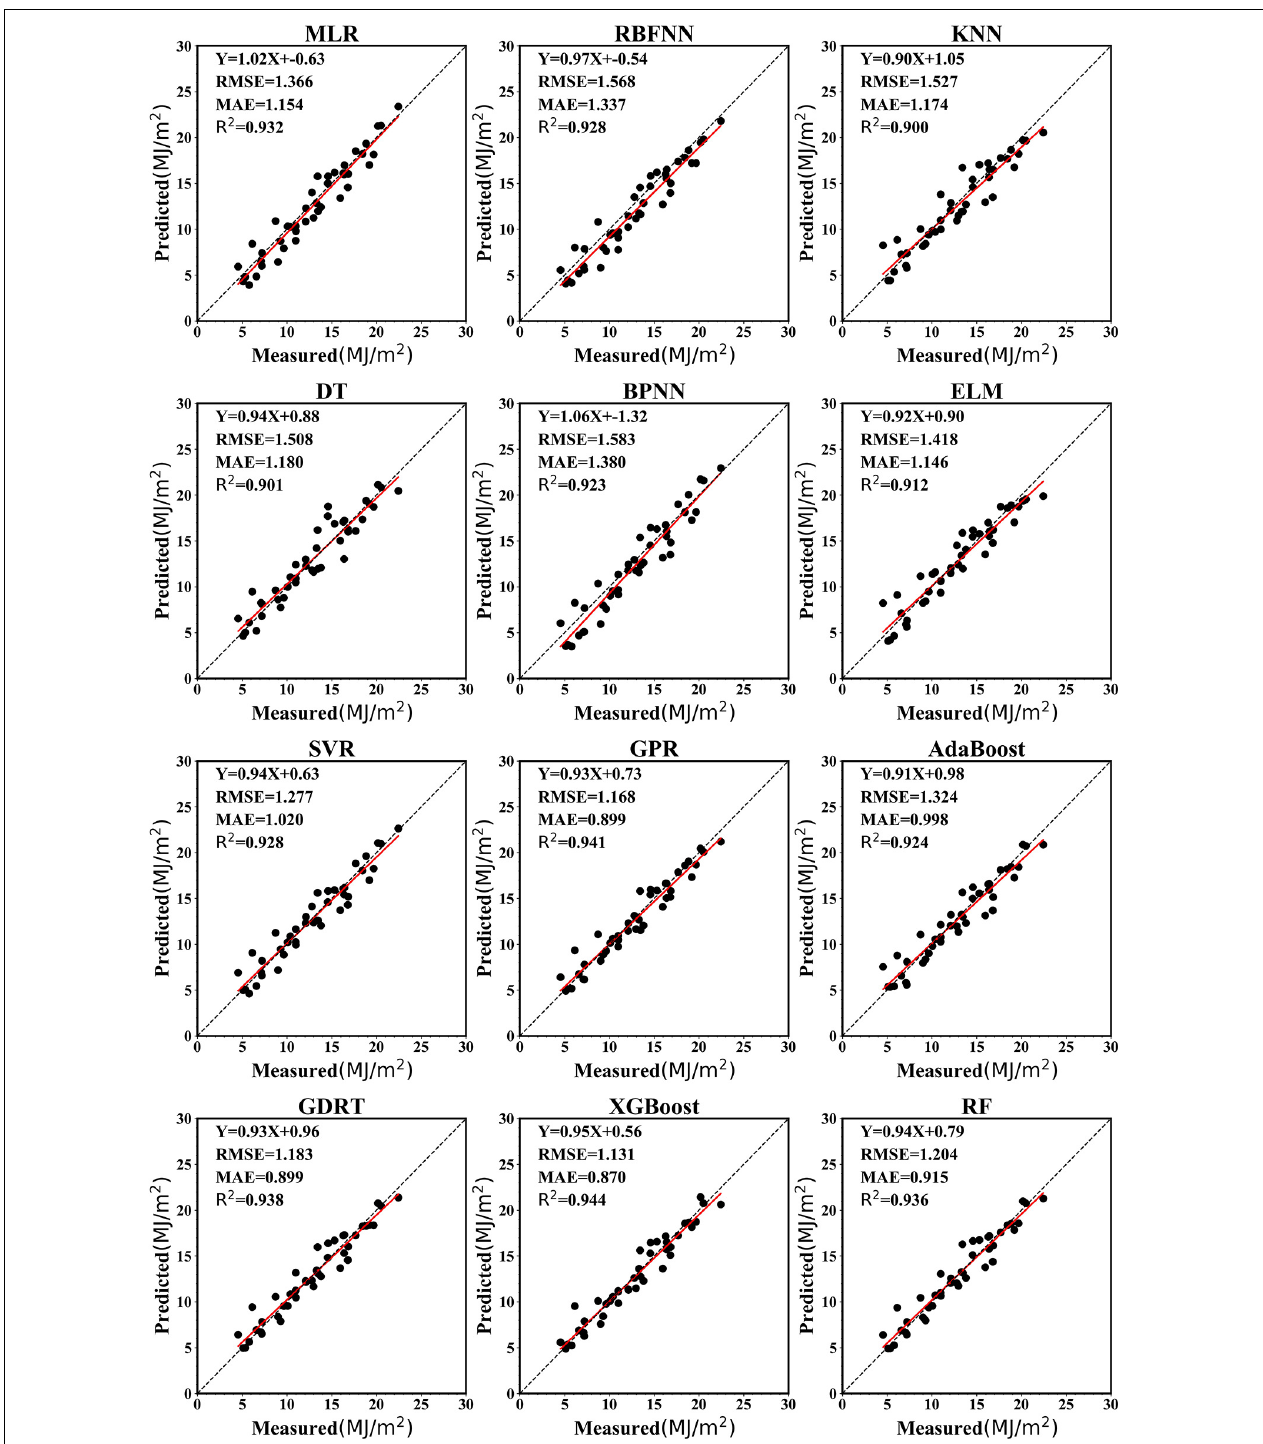
FIGURE 8 | Scatter plots of the results of machine learning models in predicting monthly average solar radiation at Ganzhou from 1980 to 2016.